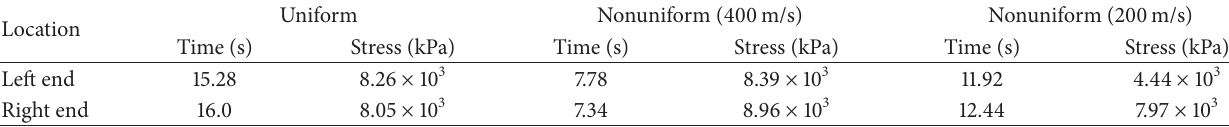
Table 5: Peak response of axial stress of steel